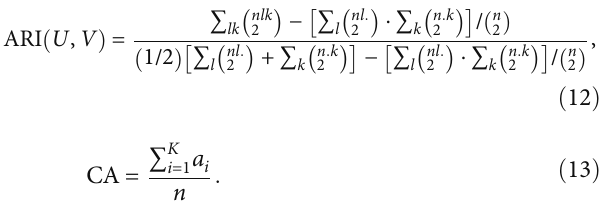
Table 1 for details of all datasets.